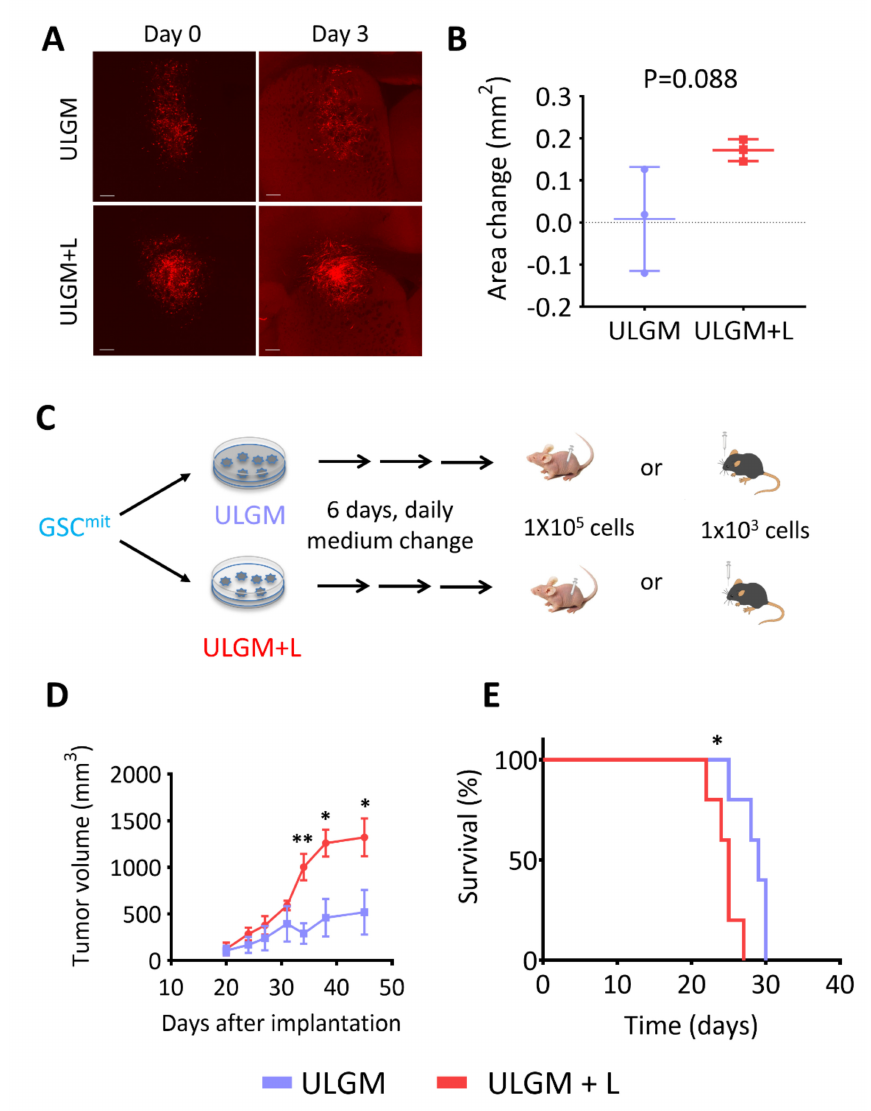
Figure 6. Lactate sustains aggressiveness of GSCs during glucose deprivation. ( A ) Red fluorescence images of organotypic brain explants isolated from mice harboring GSCB cell–derived tumors and cultured in ULGM or ULGM+L for 0 or 3 days. Scale bars, 300 µ m. ( B ) Change in tumor area between days 0 and 3 determined as in ( A ). Data are means ± SD for three explants. The p value was determined with the unpaired two-tailed Student’s t test. ( C ) Schematic representation of subcutaneous or intracranial implantation of GSCB cells after maintenance in ULGM or ULGM+L for 6 days. ( D ) Tumor volume at the indicated times after subcutaneous implantation of GSCB cells as in ( C ). Data are means ± SD ( n = 4 mice per group). * p < 0.05, ** p < 0.01 versus the corresponding value for ULGM (unpaired two-tailed Student’s t test). ( E ) Survival curves for mice ( n = 5 per group) after intracranial implantation of GSCB cells as in ( C ). * p < 0.05 log-rank